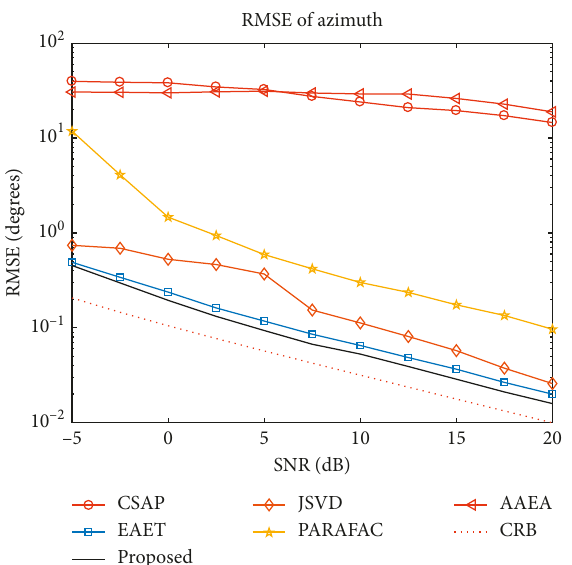
Figure 3: The RMSE of azimuth estimation versus SNR with K M 7, and J (cid:28) (cid:28)